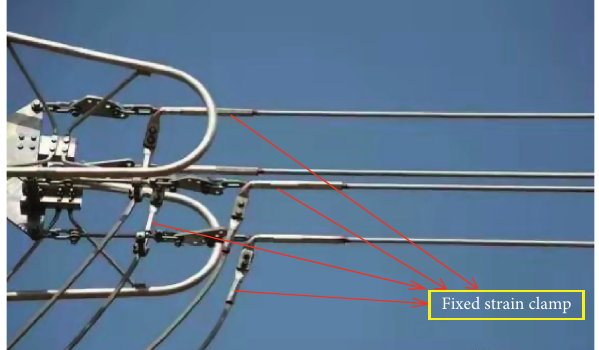
Figure 1: Connection diagram of a strain clamp for an overhead transmission